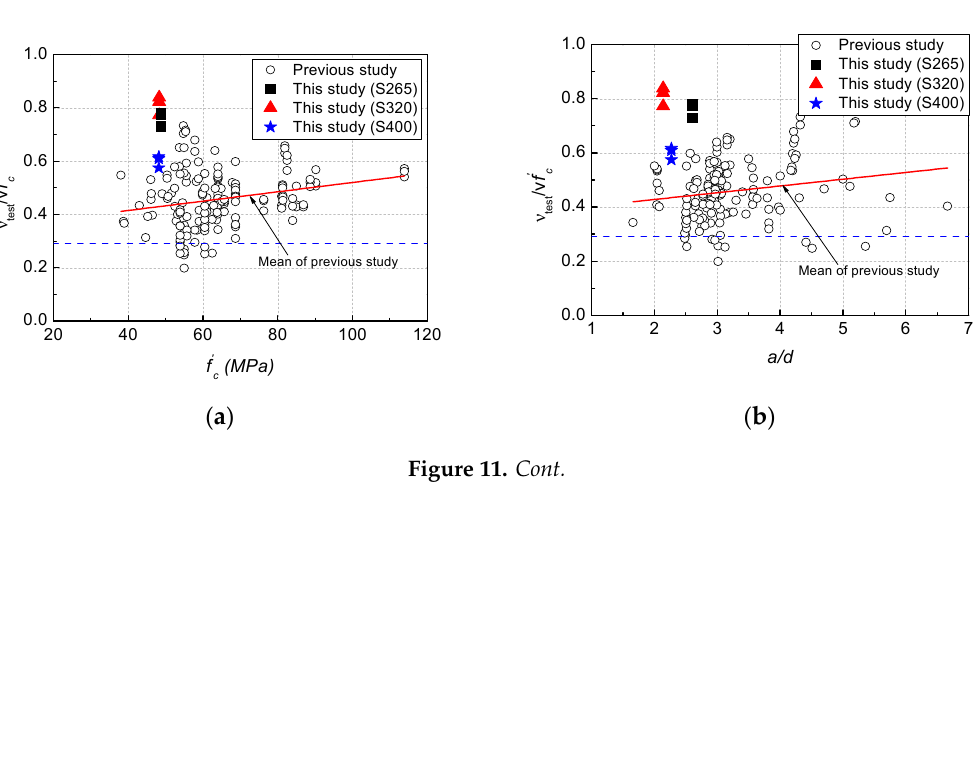
Table 4. Summary of previous studies.